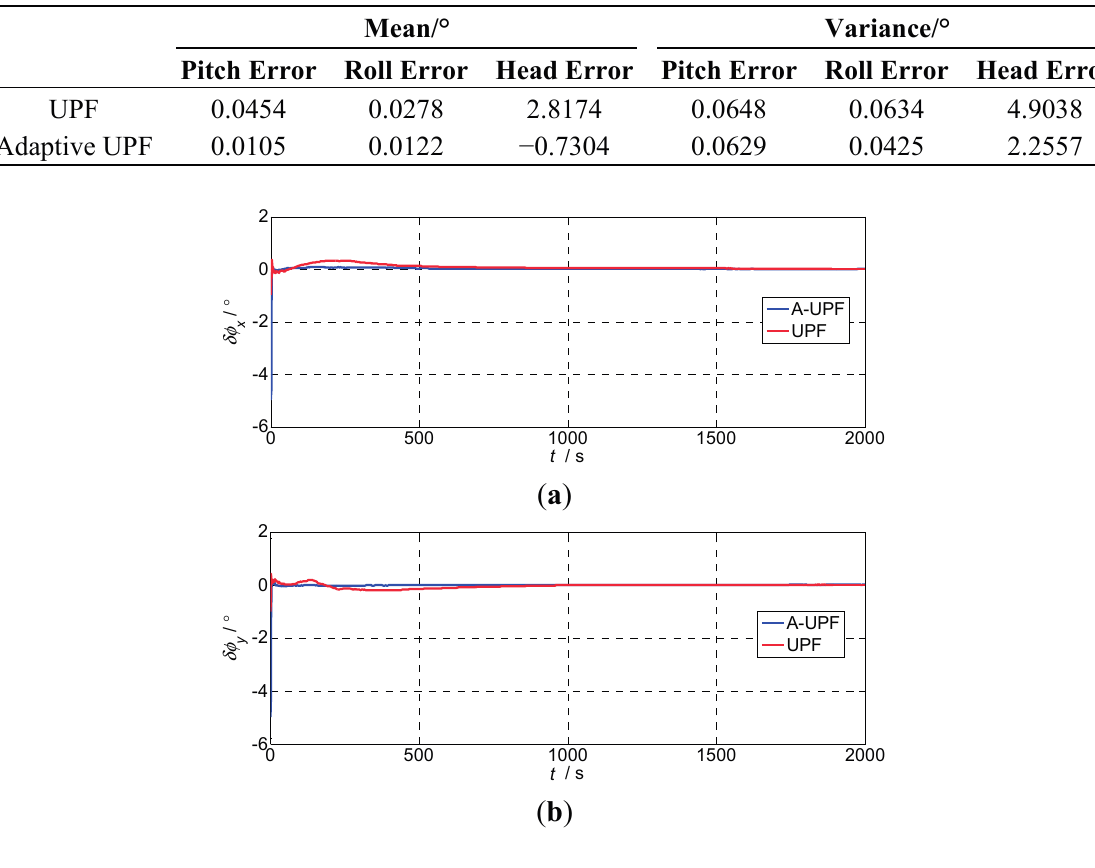
Table 2. The statistical properties of uncertain noise are the statistical results of